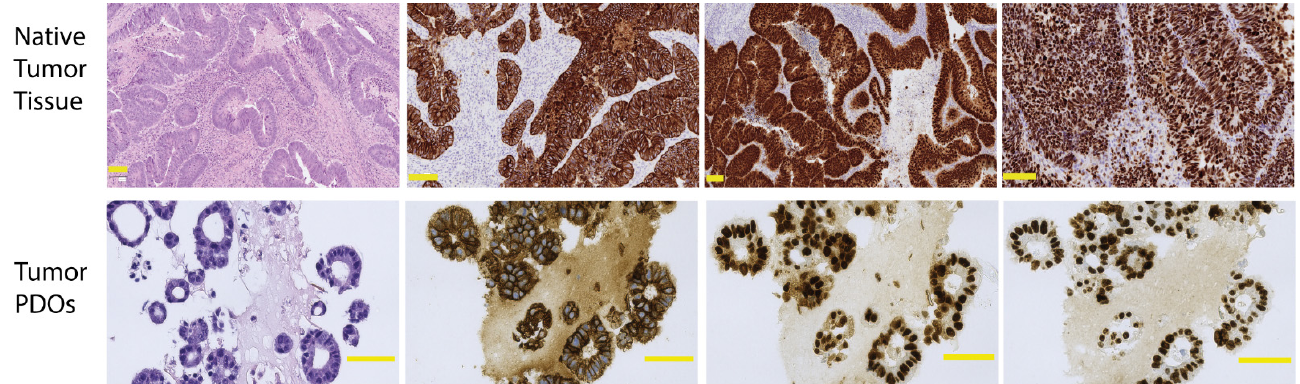
Figure 2. Immunohistochemical (IHC) analysis of patient-derived organoids and its matching sigmoid colon cancer tissue. H&E is the classical staining used to verify the morphological similarity, pan-CK is a broad-spectrum epithelial marker, CDX2 is expressed in the majority of colorectal adenocarcinomas, although not restricted to this organ, and Ki67 is a cell proliferation marker. The scanned slides are gamma-adjusted to obtain better discrimination and all bars represent 100 μ m. Images are obtained from a resected tumor of a patient operated on at Zealand University